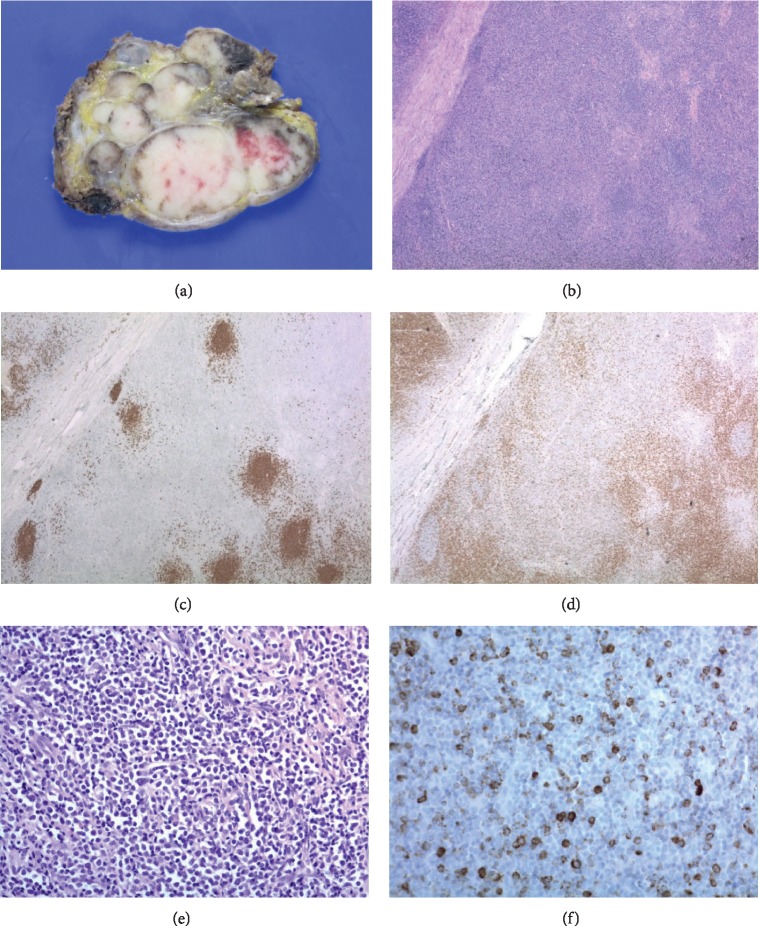
(a) The dissected neck lymph nodes were conglomerated. (b) Normal architecture of the lymph node was faded, and paracortical expansion by large neoplastic cells was noted (×40). (c) Immunohistochemical (IHC) staining of CD20 showed reactive follicles predominantly composed of B cells. (d) IHC staining of CD3 highlighted paracortical areas populated by T cells (×40). (e, f) Neoplastic cells with scant cytoplasm and irregular nuclei showed strong myeloperoxidase expression (×400).